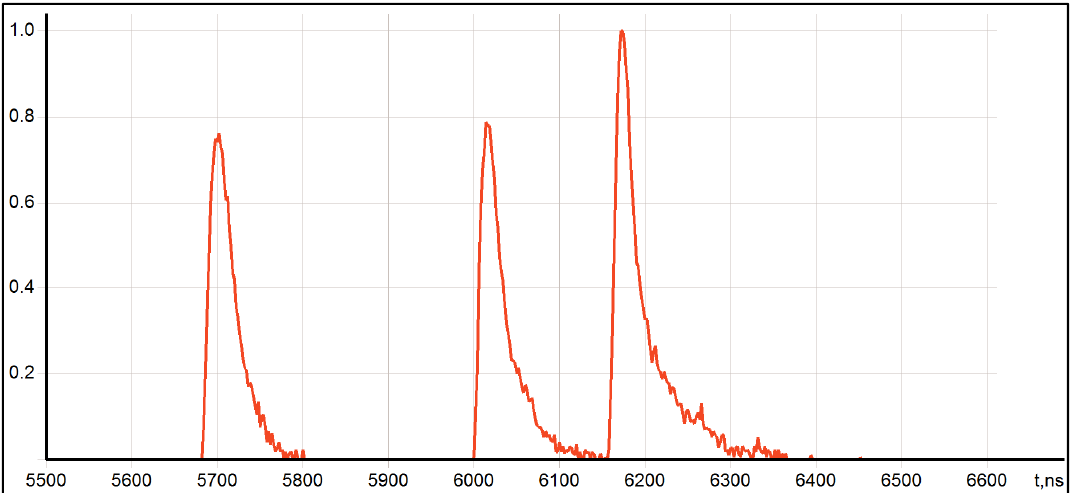
Figure 2. A sample of EAS event with multi-modal (triple) scintillation response to the passage of successive shower fronts. The time delays between the scintillations are 318 ns and 465 ns, correspondingly for the second and third pulses relative to the leading one. The energy of the primary cosmic ray particle in the shower was ~500 PeV and the zenith angle of the particle trajectory was about 30°. Y axis title: normalized max value of ADC code.